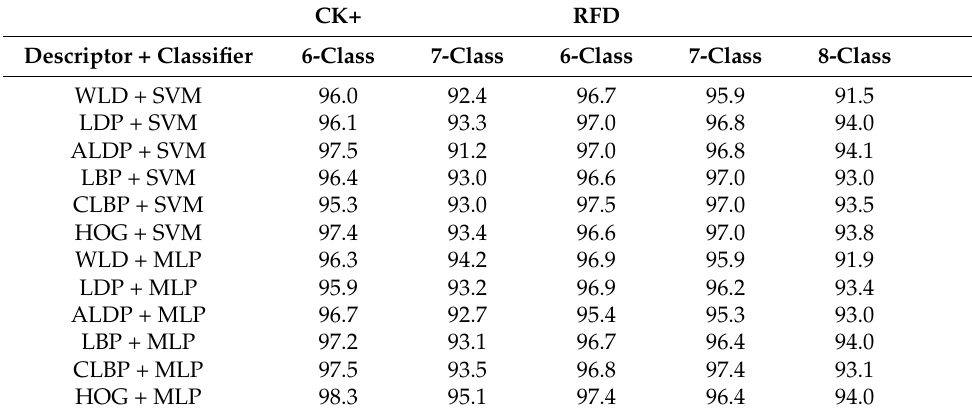
Figure 7. FER results for the best of sub-regions on the RFD dataset (6 expressions). Table 4. Comparison of recognition rates on the CK+ and RFD datasets with a varying number of